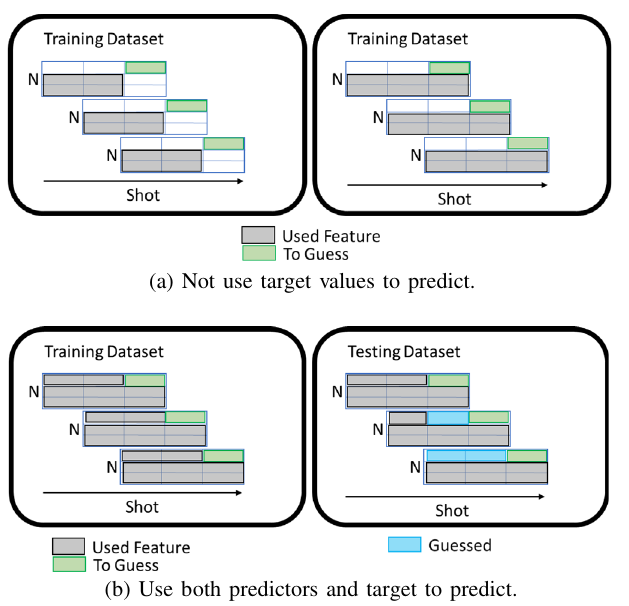
FIG. 15. Possible setup for time series prediction. Each grid denotes a time step; the time window is taken within one shot of the electron pulse. The gray areas are the input of the model, used as a predictors to predict the target, while N denotes the number of input features. The green areas are the target value expected to be predicted at each time step. (a) Predictors (gray) and target (green) are different variables, while the left and right plots show whether to include the present predictors to predict the present target. (b) Target is included as predictor. In the right plot, past predictions of the target (blue) are used in the testing dataset (from [78], Figs. 4